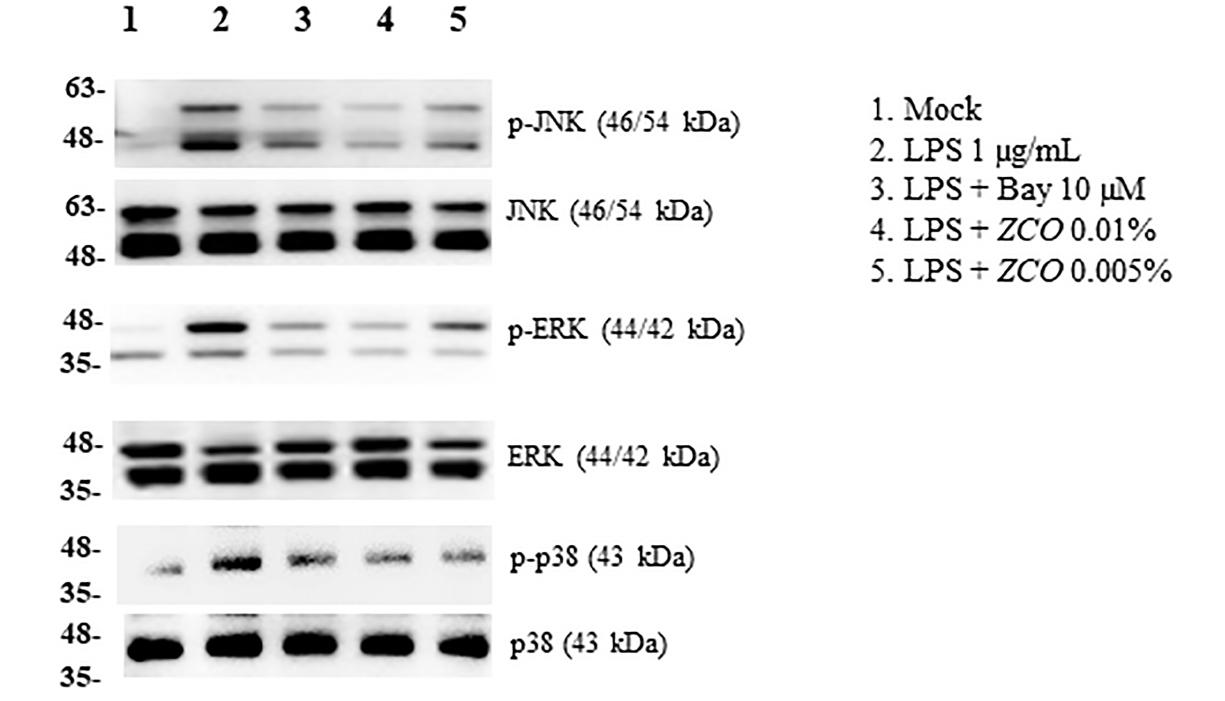
FIGURE 7 | Effect of ZCO on MAPKs in LPS-activated RAW264.7 cells. RAW264.7 cells cultured into 6-well plate were pretreated with ZCO (0.01 and 0.005%) or Bay11-7082 (10 µ M) for 4 h, and then stimulated with LPS (1 µ g/mL) for 30 min. Cell lysates (50 µ g) were used for Western blotting of the target proteins. Phosphorylated MAPKs were detected by using anti-phospho-JNK, anti-phospho-ERK or anti-phospho-p38 antibody. The membrane was stripped and reassessed with the antibodies targeting non-phosphorylated